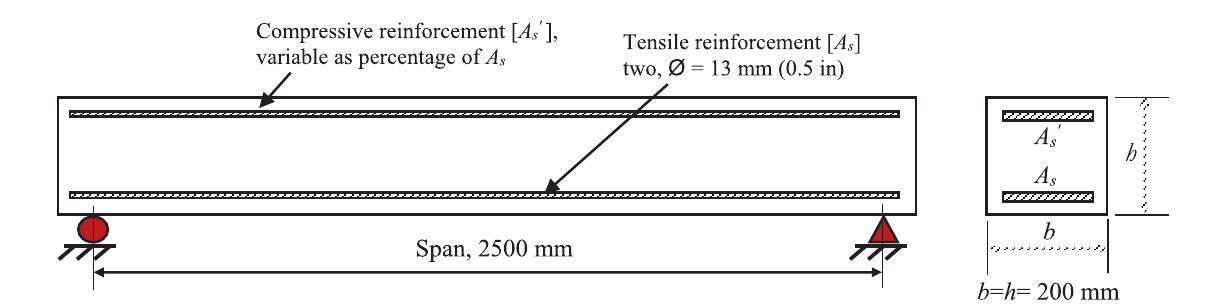
Figure 1 Dimensions of RC beam used in the parametric study